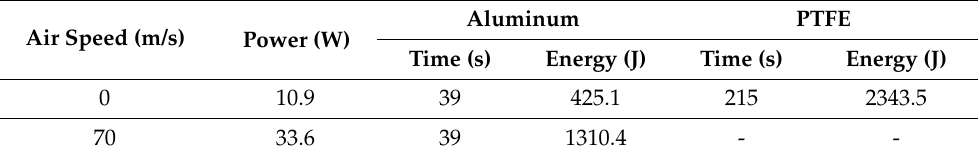
Table 3. Time and energy consumption to reach 5 ◦ C in the whole heated surface. Aluminum PTFE Air Speed (m/s) Power (W) Time (s) Energy (J) Time (s) Energy (J) 0 10.9 39 425.1 215 2343.5 70 33.6 39 1310.4 -